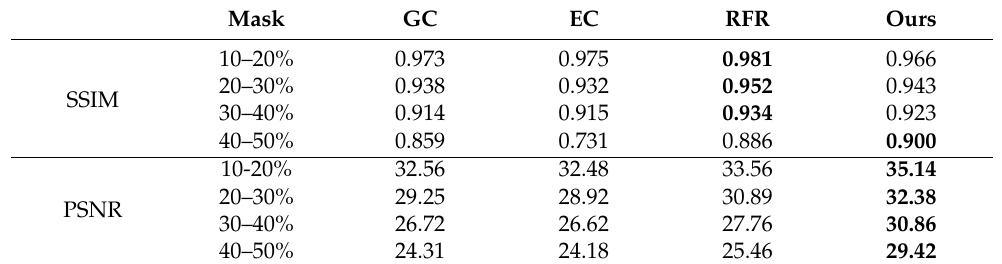
Table 1. Quantitative comparison results when the proportion of the mask to the image is 10–50%.